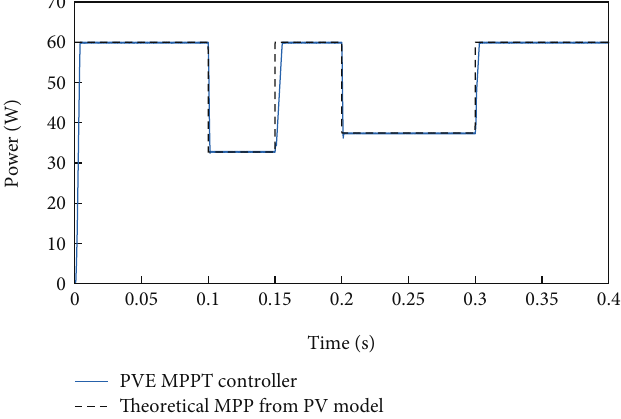
Figure 26: Power of the PVE system with MPPT control under fast-changing environmental